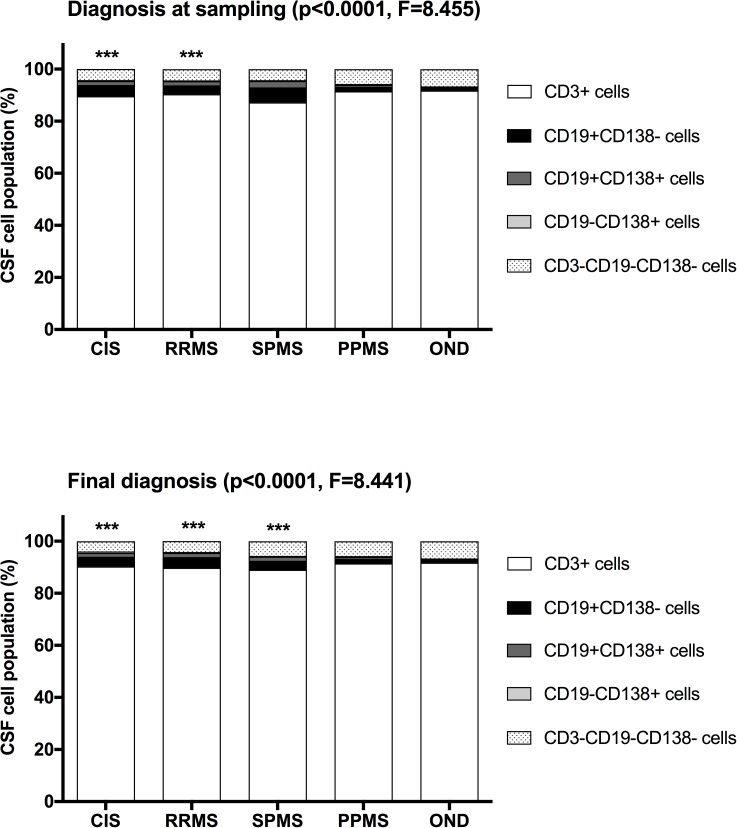
CSF lymphocyte populations in CIS, RRMS, SPMS, PPMS and OND at sampling and last follow up.Bars represent mean of individual CSF cell populations. Log-transformed data were compared using mixed (paired 2-way) ANOVA with sex, age and CSF leukocyte cell numbers as covariates to exclude confounders. *** significant difference to OND (p<0.001).